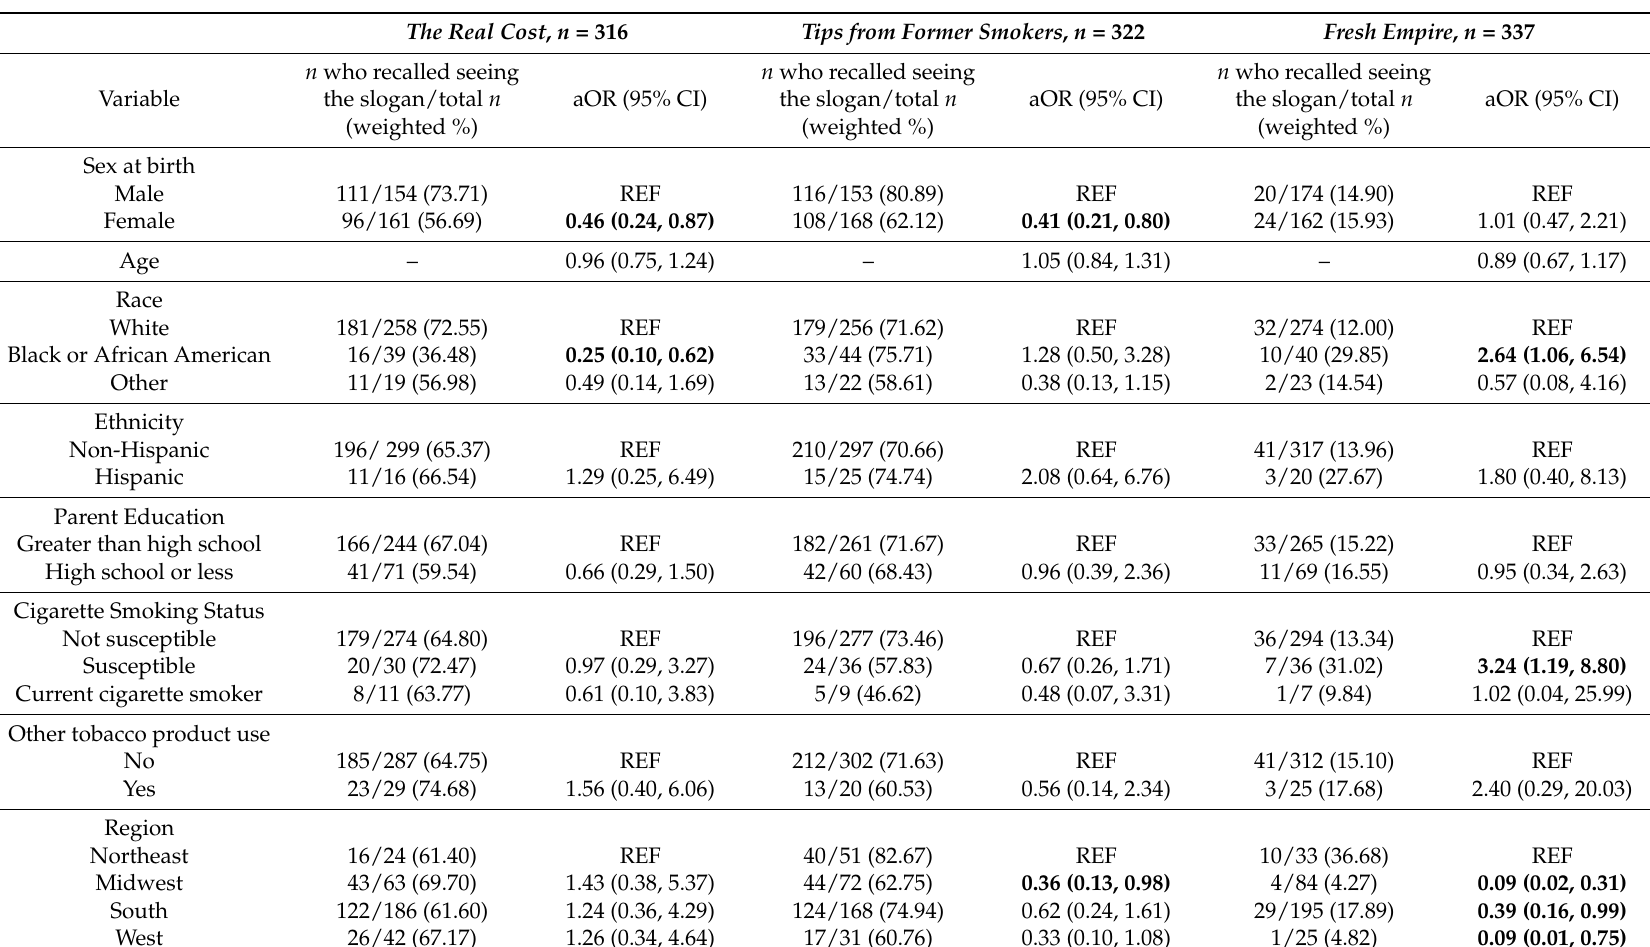
Table 2. Weighted logistic regression results for aided recall of slogans from a national sample of adolescents, conducted by the Carolina Survey Research